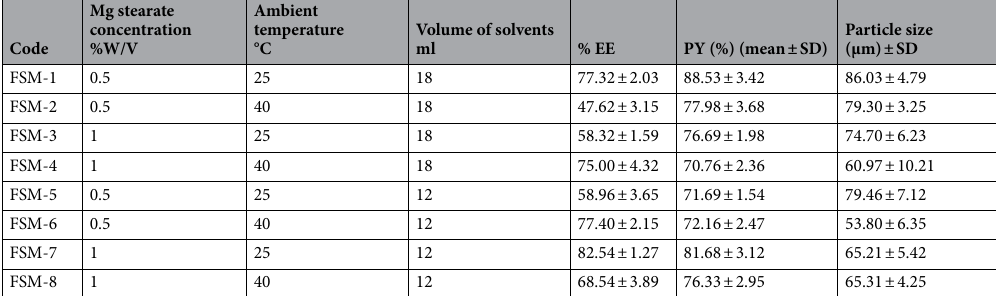
Table 1. Composition, %EE, PY, particle size, and PDI of different microsponges formulations.